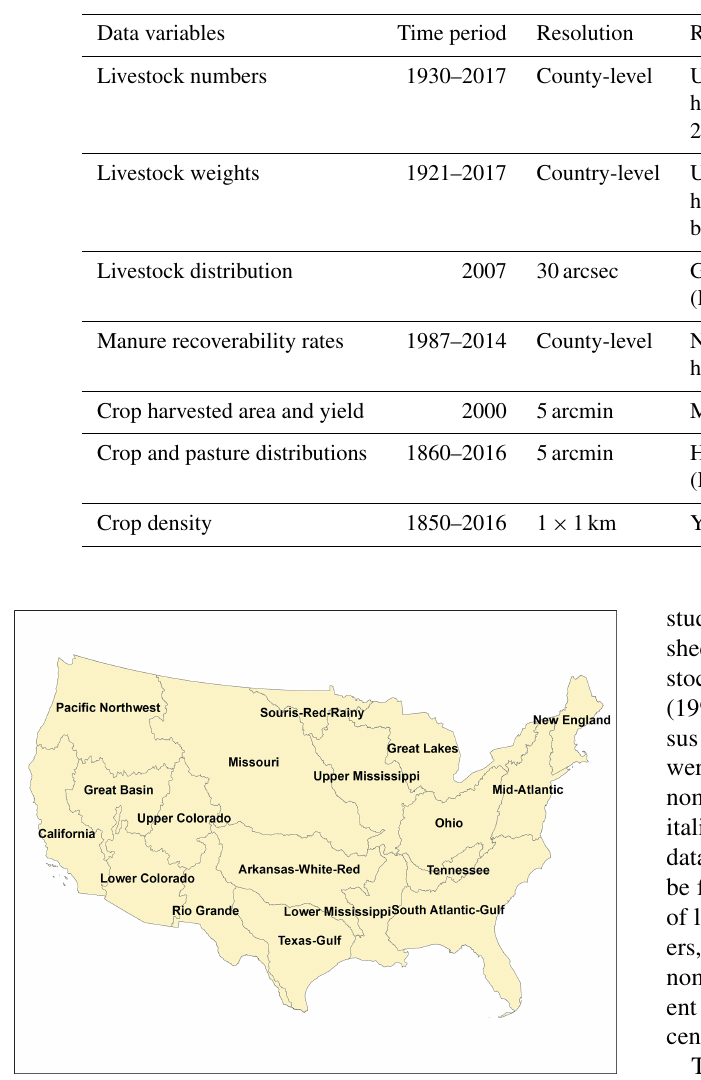
Table 1. Summary of data sources.